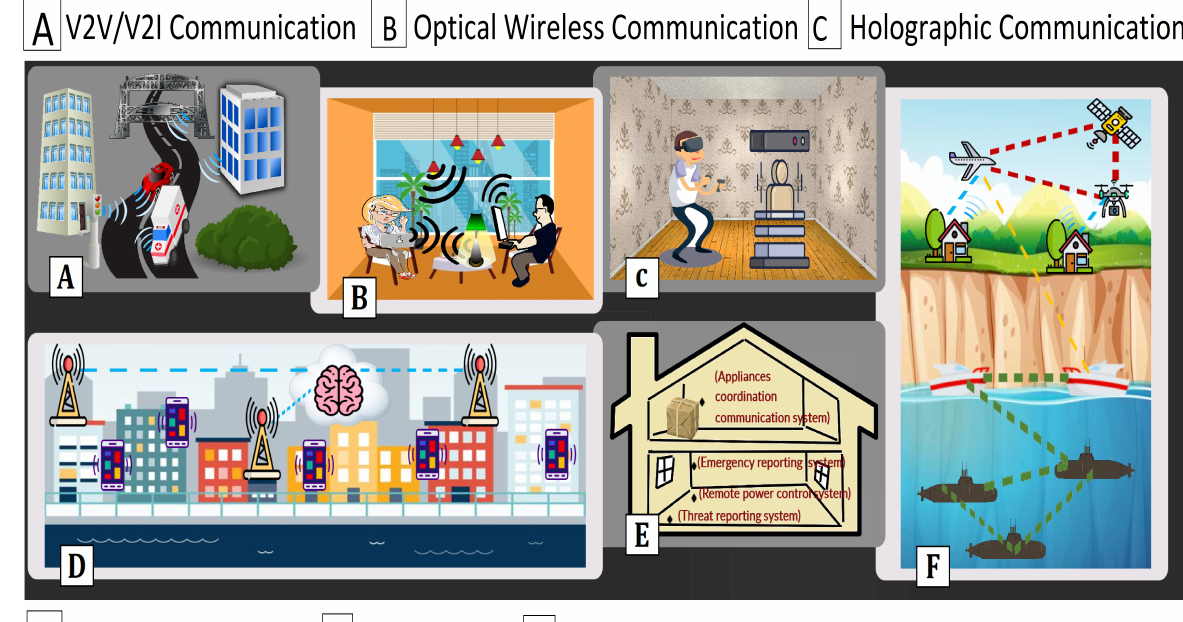
Figure 5. Some of the 6G system’s